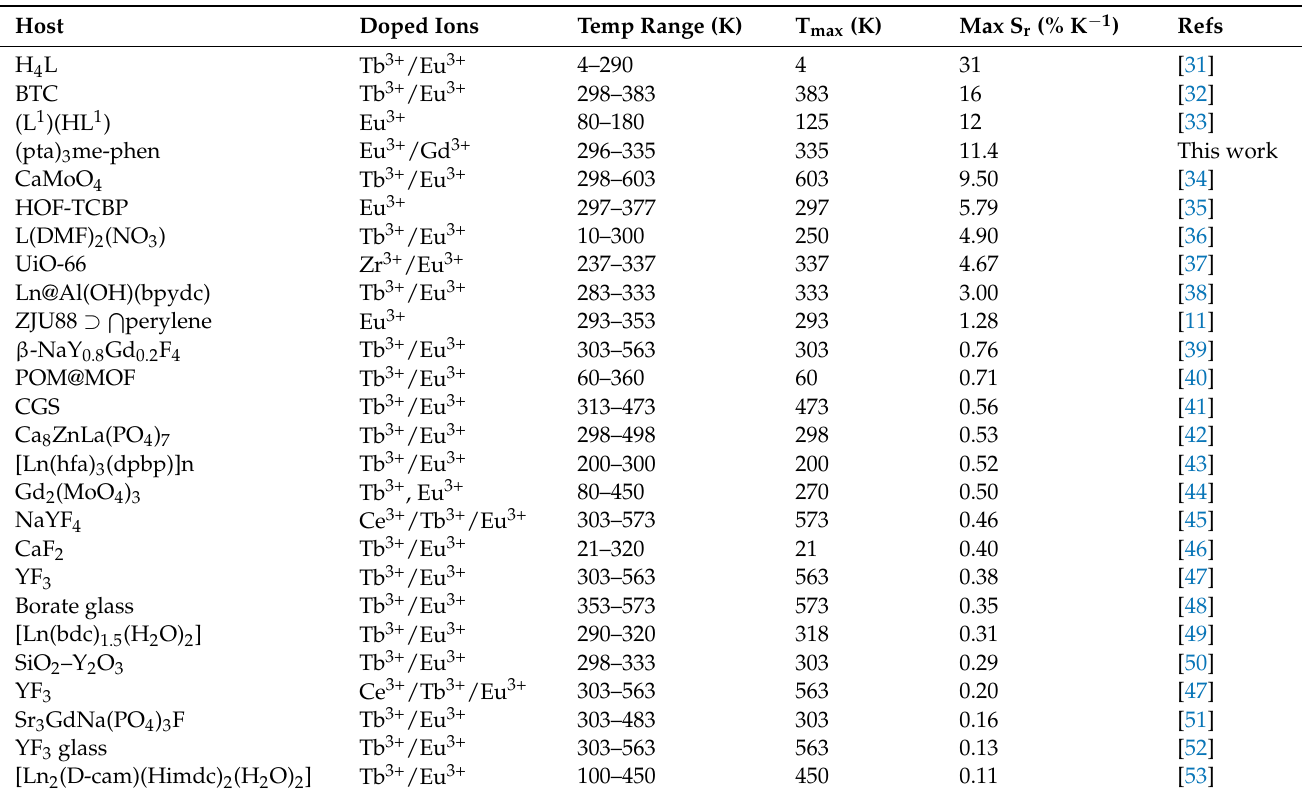
Table 4. List of optical temperature sensors based on Eu 3+ -doped lanthanide ions, ranked by relative